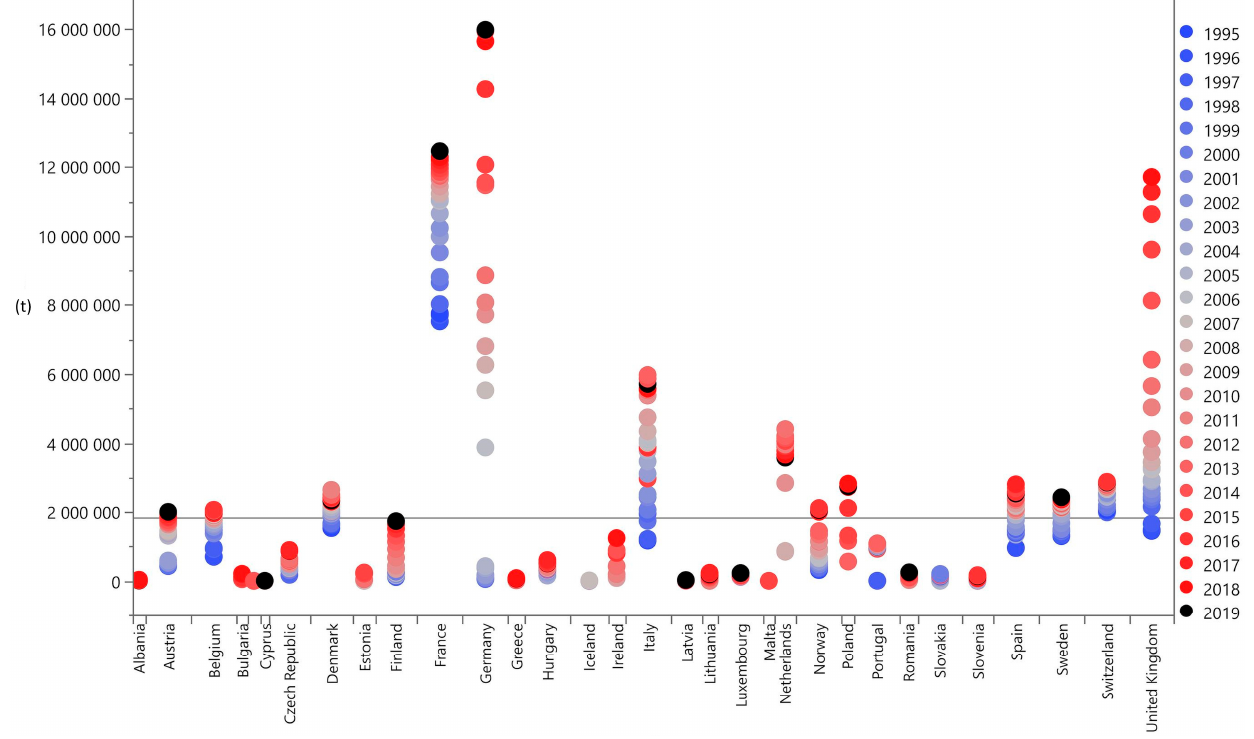
Figure 12. Energy recovery from municipal waste in the EU for the years 1995–2019.